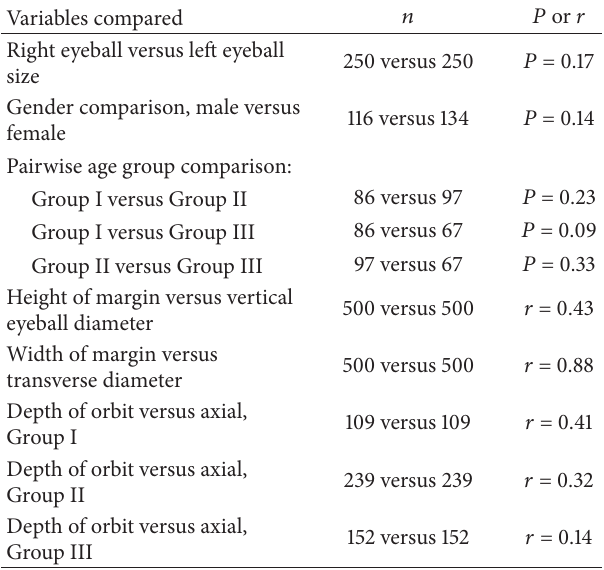
Table 2: Comparison and correlation of the obtained measure-